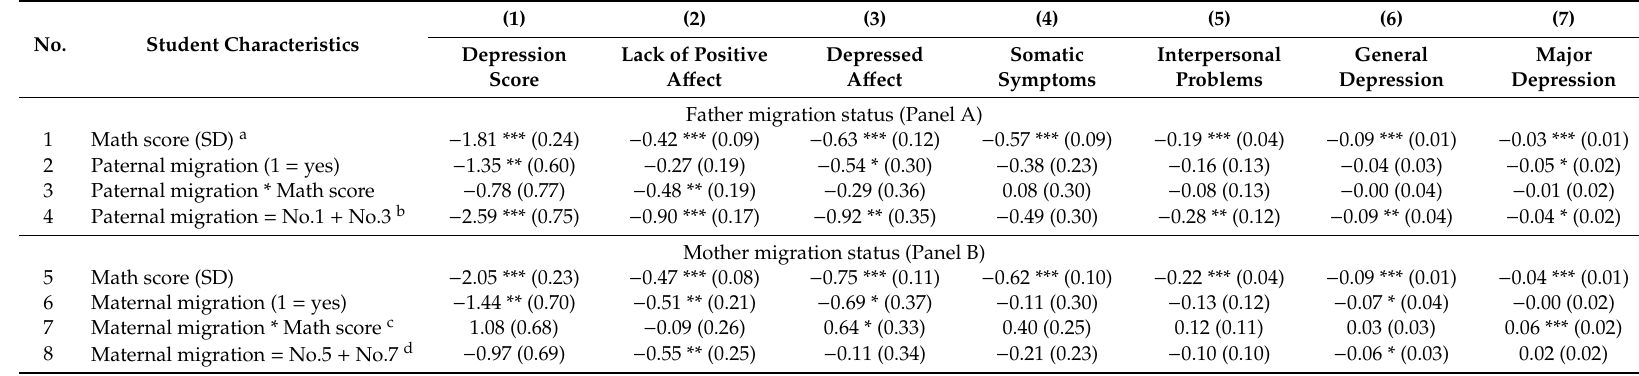
Table 6. OLS regression results showing heterogeneous effects of academic performance on depressive symptoms between different parental migration status, N = 1655.